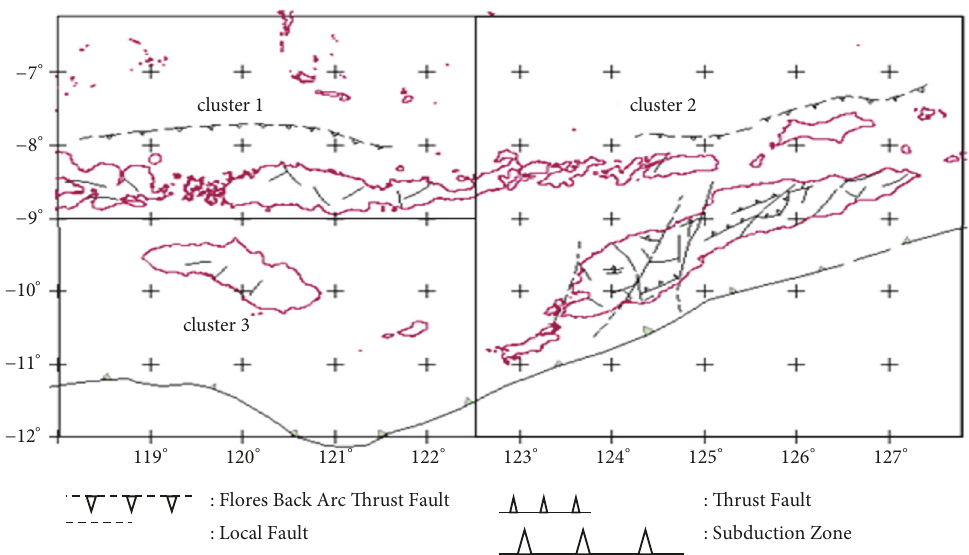
Figure 2: Clusters distribution of ENTP and surrounding areas used to find the differences of b-value for each region.